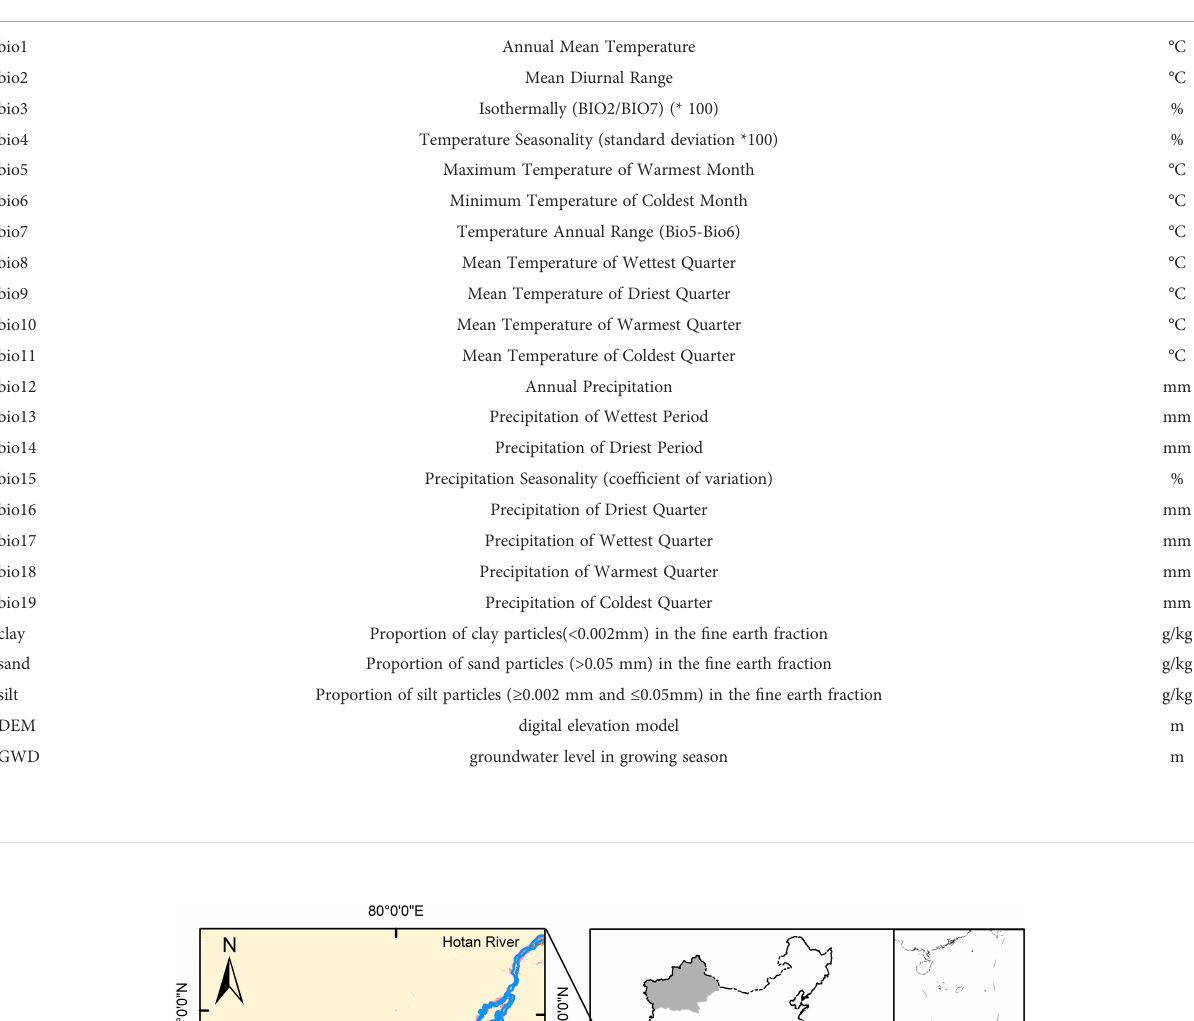
TABLE 1 Description of bioclimatic variables used for MaxEnt model